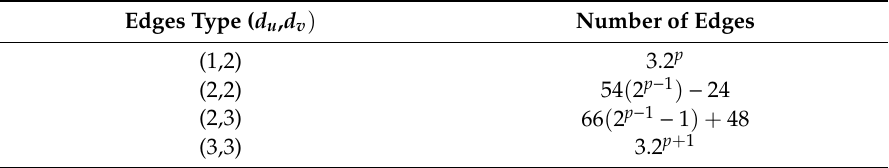
Table 5. Edge partition of polymer